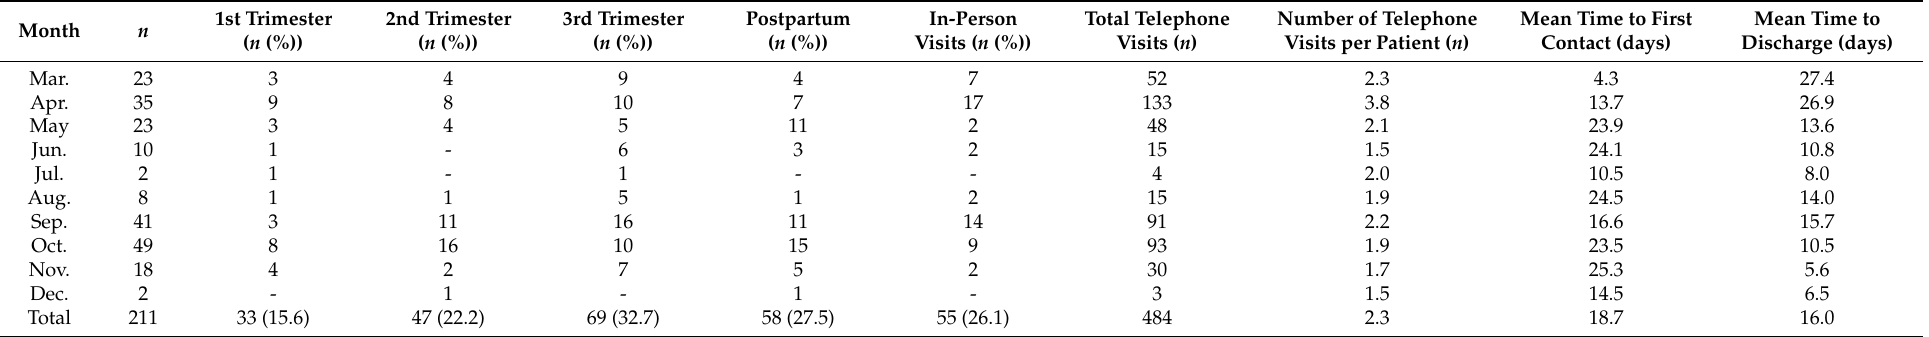
Table 1. Descriptive results of Pregnancy and COVID-19 program: obstetric patients ( n ; number) from each trimester and postpartum, type of medical assistance, and managed times (days) in function of time (months of